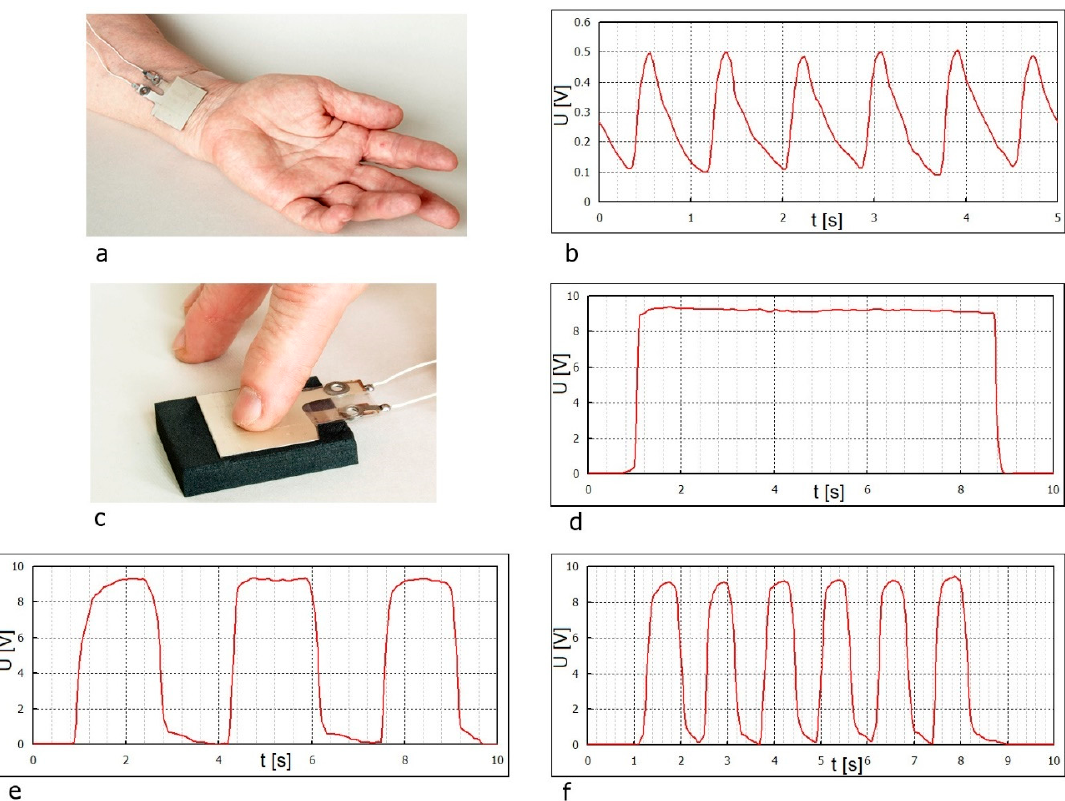
Figure 5. Example of the sensor application for medical use: Blood pulse measurement ( a ), dependence of the piezoelectric voltage arising from the artery pulsation ( b ), finger pressure measurement ( c ), piezoelectric voltage curves for variable finger pressure frequencies ( d – f ). The piezoelectric element was made of i-PP oriented film with 5 wt% Sillikolloid P87.